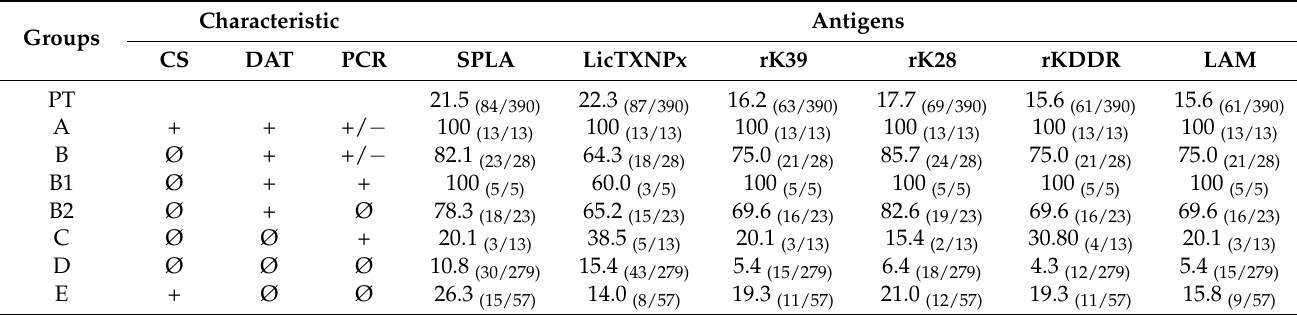
Table 3. General characteristics and seropositivity percentages and absolute numbers, between brackets, in the different cohorts for SPLA, LicTXNPx, rK39, rK28, rKDDR, and LAM. The charac- teristics CS (clinical signs), DAT (direct agglutination test), and PCR (Positive PCR result for Leish- mania genetic material) are labell ed as: “+” (positive); “ − “ (negative); Ø (Absent).